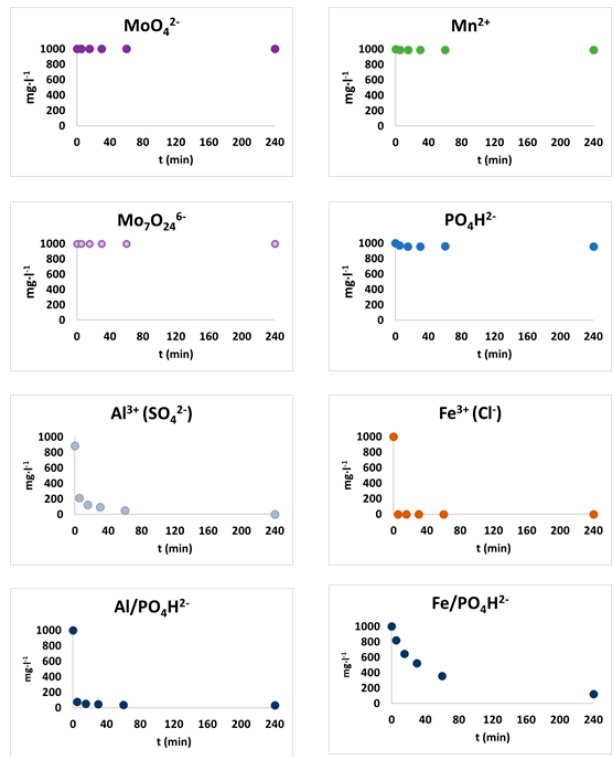
Figure 2. Nutrients-biochar adsorption isotherms.